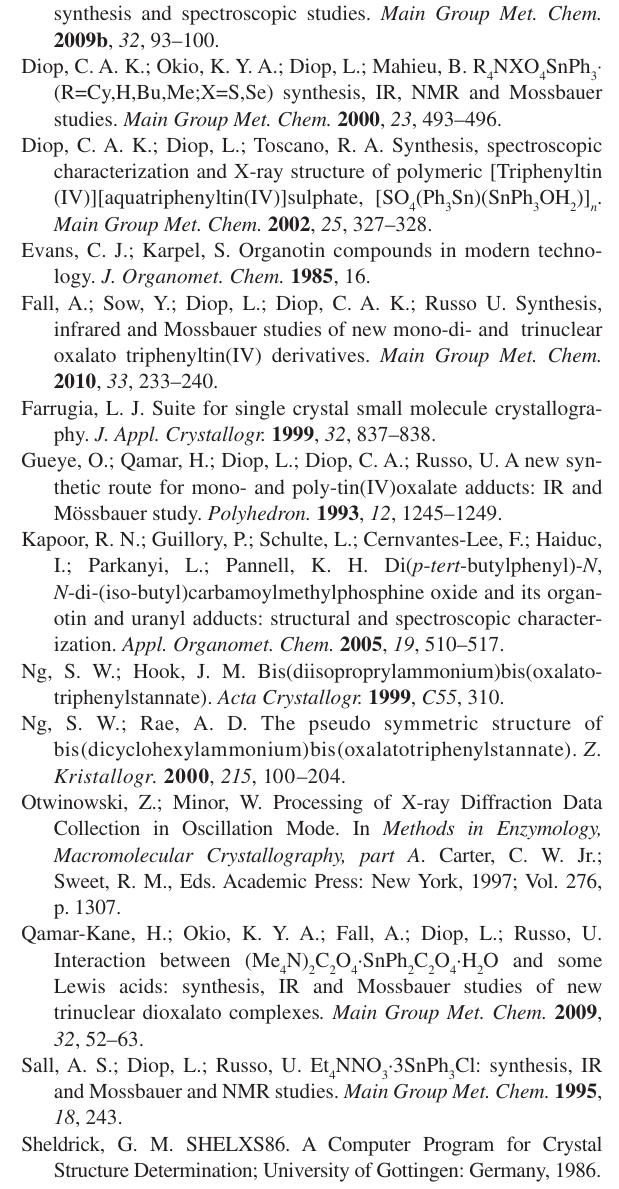
Table 2 Crystal data and structure refi